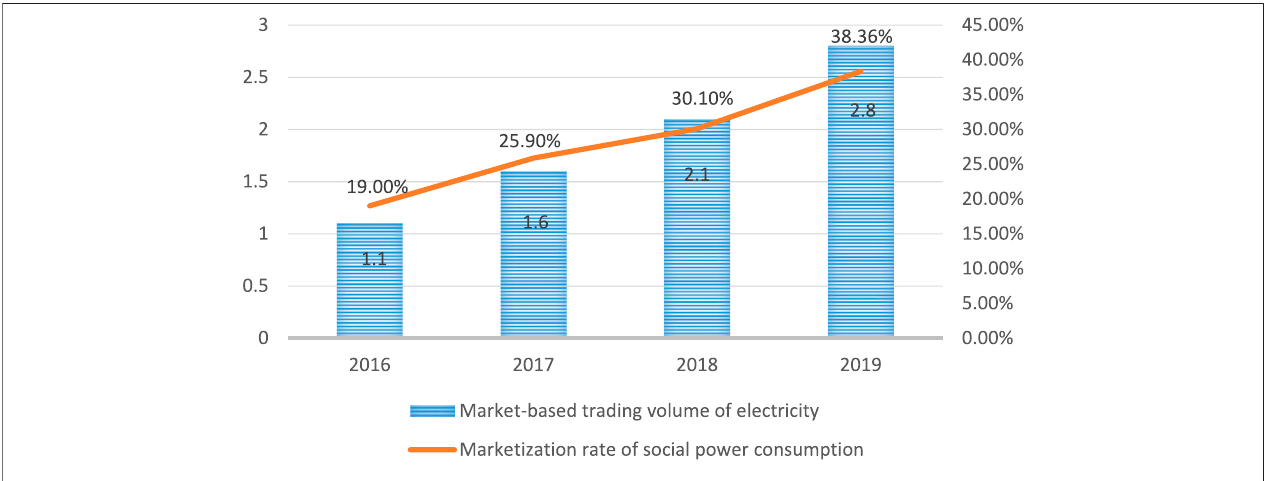
FIGURE 1 | 2016 – 2019 power market traded electricity and its share in the nation ’ s power consumption (unit: trillion kWh, %).